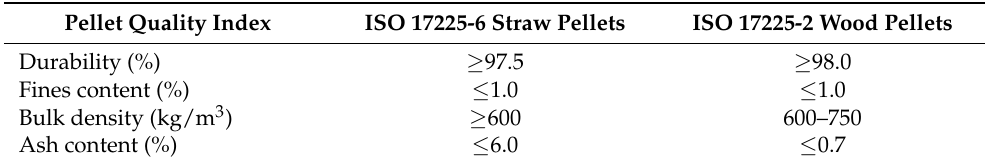
Table 4. International standards (ISO 17225) for straw pellets and commercial, residential wood pellets